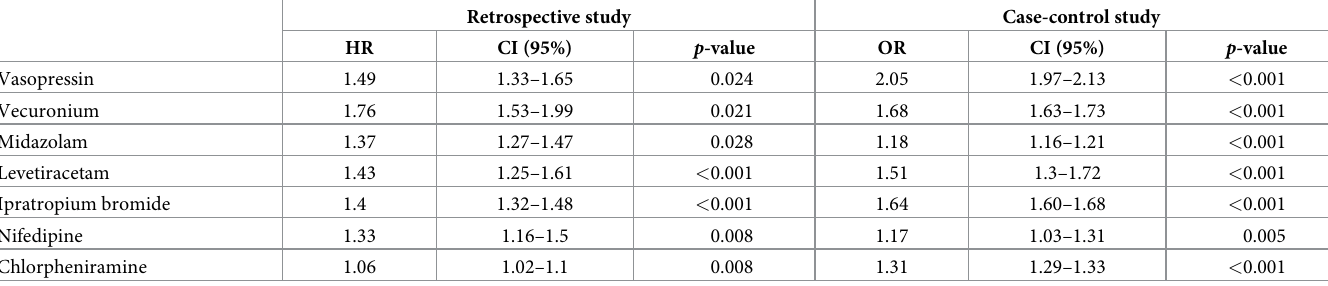
Table 3. Hazard and odds ratios for seven drugs with significant QT prolongation